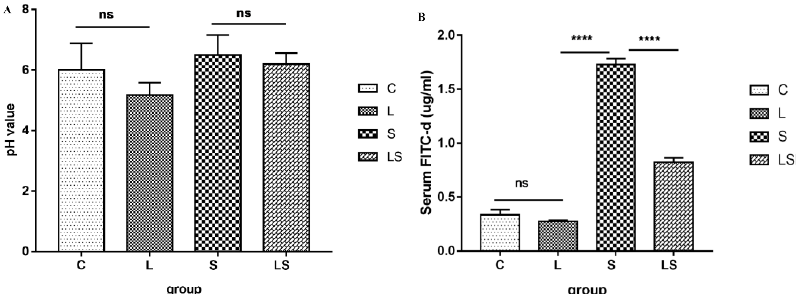
Figure 1. (A ) pH value of chicken cecum; ( B ) Chicken intestinal permeability. C = control group, L = L. reuteri S5 group, S = S. enteritidis infection group and LS = L. reteri S5 + S. enteritidis group. ns indicates that the comparison between the two groups is not significant, **** means p < 0.0001. To evaluate the protective effect of L. reuteri S5 on the chicken intestine, the Salmonella bacteria present in the ceca were counted in groups LS and S. The bacterial load of liver, lung and kidney in group LS was significantly lower than that in group S ( p < 0.05). There was no significant difference in the bacterial load of heart and spleen between the two groups ( p > 0.05), as shown in Figure 2. Figure 2. Tissue bacterial count. S = S. enteritidis infection group and LS = L. reteri S5 + S. enteritidis group. ns indicates that the comparison between the two groups is not significant. * means p < 0.05, ** means p < 0.01. 3.2. Effects of L. reuteri S5 on Intestinal Microbiota of Chicken Ceca The colony counts of lactic acid bacteria in the chicken ceca were significantly higher in group L than in group C ( p < 0.05) and were higher in group LS than in group S, but the difference was not significant ( p > 0.05), as shown in Figure 3A. The colony counts of Sal- monella in the chicken ceca were significantly lower in group L than in group S ( p < 0.01), and the counts of Salmonella were also lower in group LS than in group S, but the differ- ence was not significant ( p > 0.05), as shown in Figure 3B.